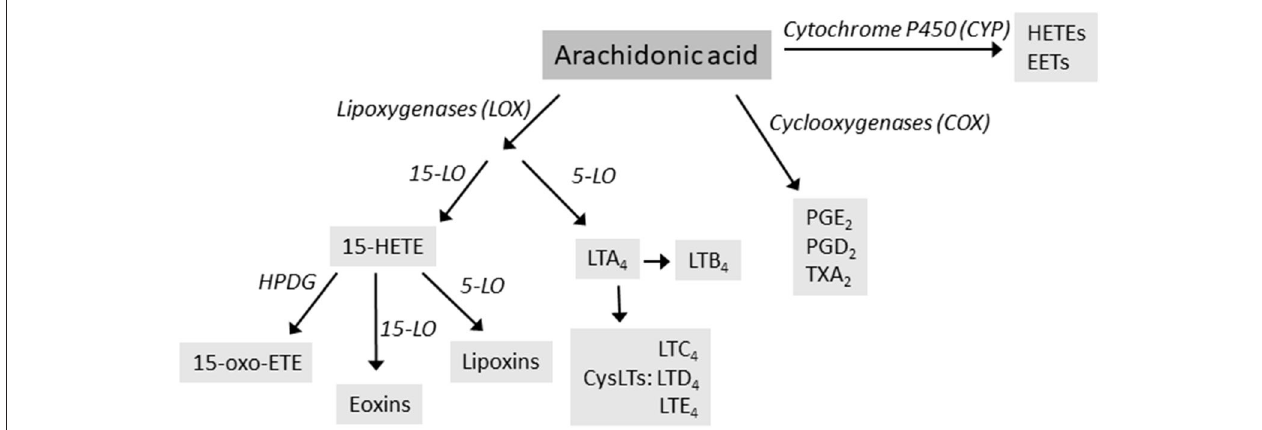
FIGURE 1 | The main routes of arachidonic acid metabolism, focusing on lipoxygenase (LOX) pathway. Enzymes are in italics. HETE, hydroxyeicosatetraneoic acid; LT, leukotrienes; PG, prostaglandins; TX, thromboxanes.